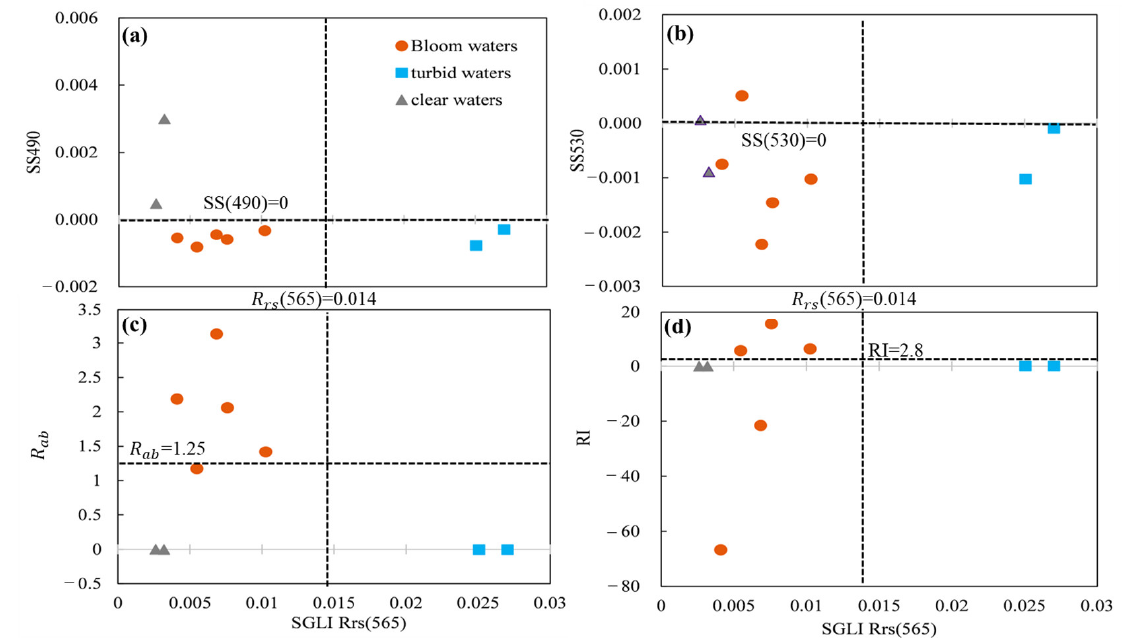
Figure 5. Scatterplots of different water types indicated by ( a ) SS(490), ( b ) SS(530), ( c ) R ab , and ( d ) RI. The data were derived from the satellite R rs ( λ ) in Figure 4. The horizontal black dotted lines represent ( a ) SS(490) = 0, ( b ) SS(530) = 0, ( c ) R ab = 1.25, and ( d ) RI = 2.8. The vertical broken lines represent R rs ( 565 ) = 0.0014 sr − 1 .